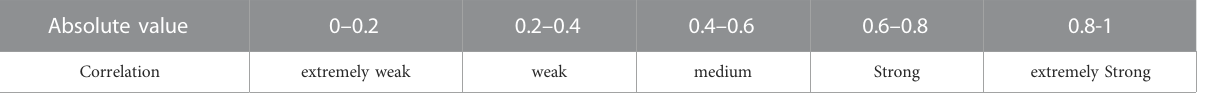
TABLE 1 Correlation table. Absolute